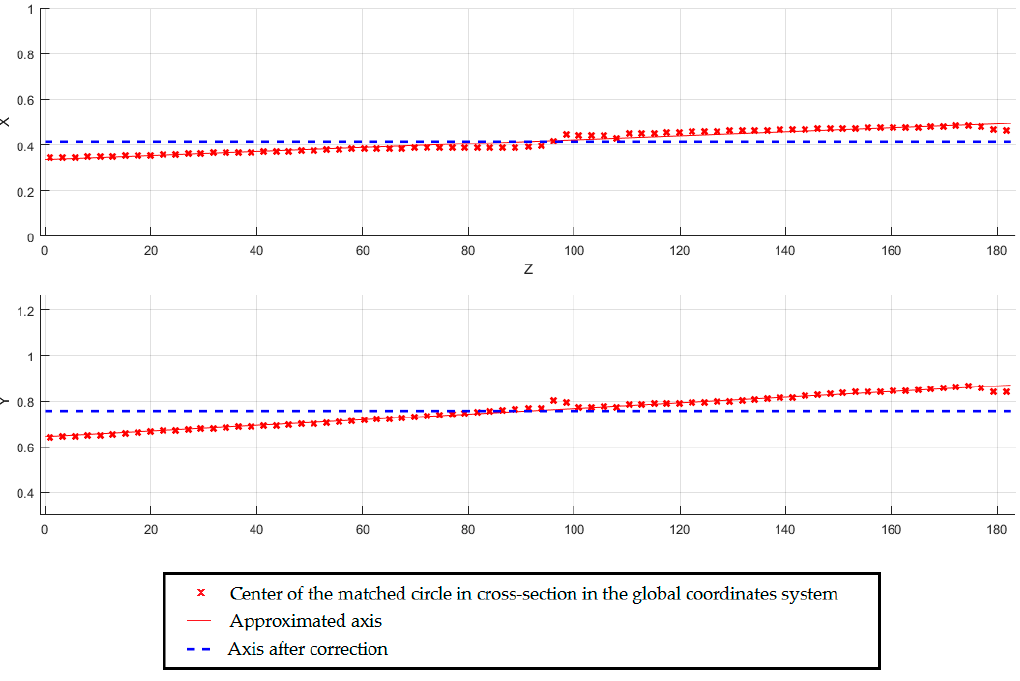
Figure 7. Overview of the shaft axis in XZ plane and YZ plane.